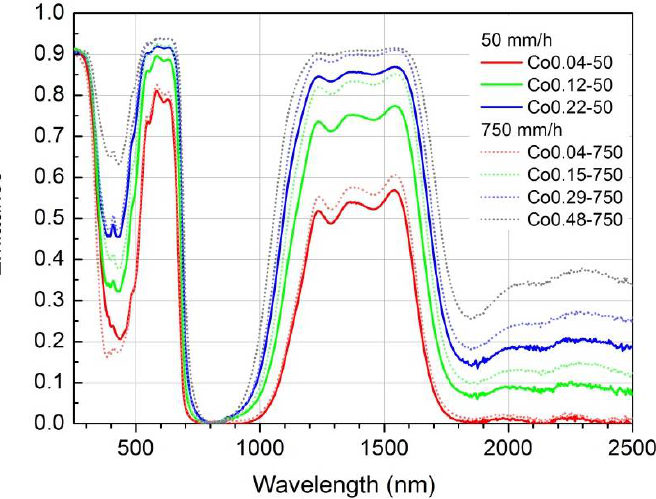
Figure 9. Estimated directional spectral emittance at room temperature of the different eutectic samples. The apparent structure of the band above 1900 nm might be an artifact of the spectrograph.